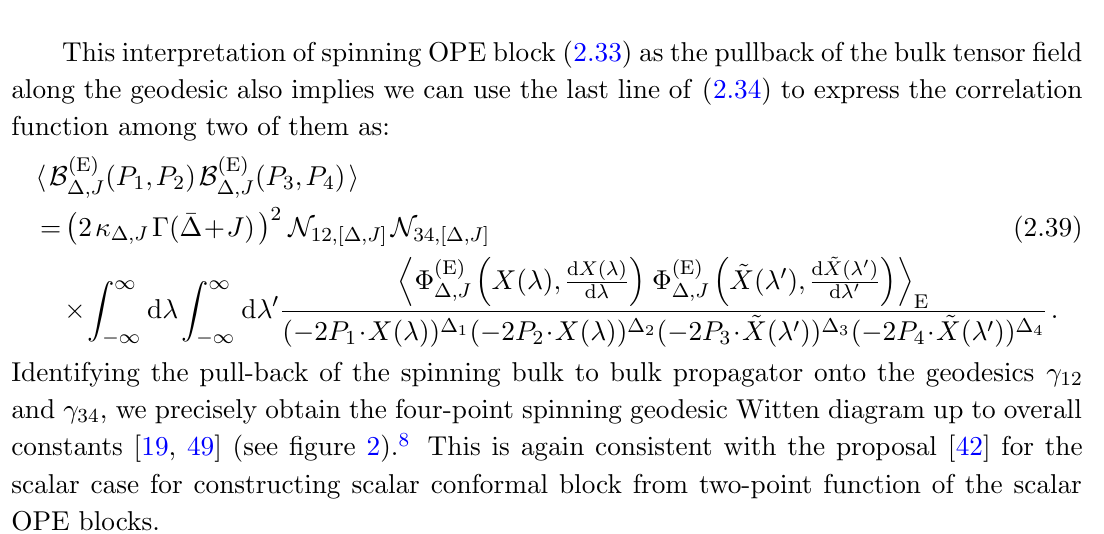
Figure 2 . The geodesic Witten diagram as two-point function of the OPE blocks. The dashed black line represents the bulk to bulk propagator of the spinning bulk (cid:12)eld from a point on (cid:13) 12 to another on (cid:13) 34